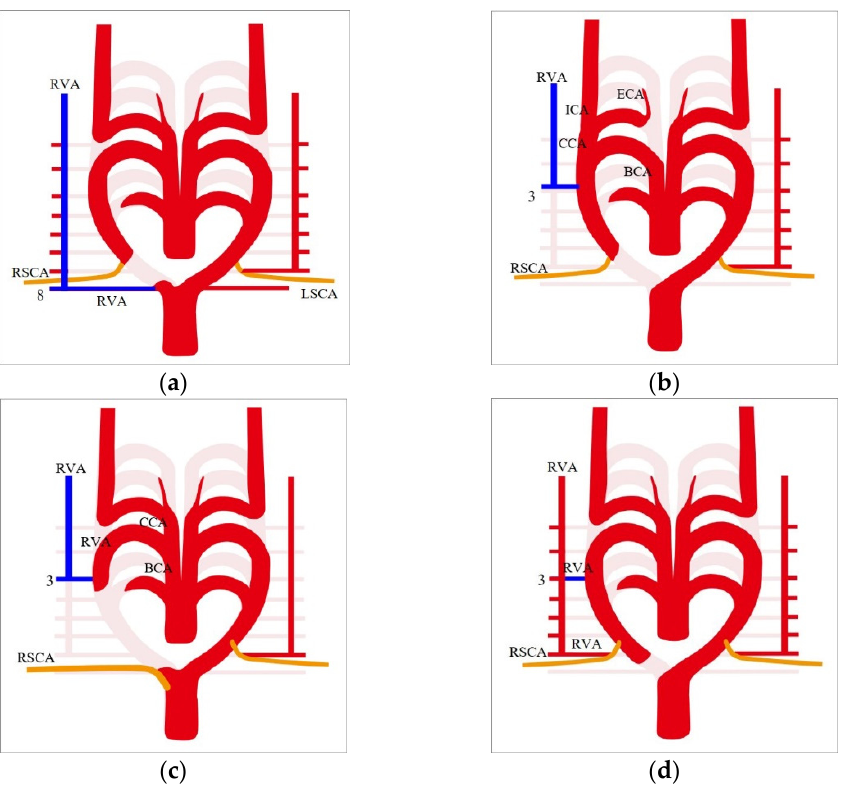
Figure 2. Drawing of the variations of the anomalous origin of the RVA. ( a ) Aortic origin of the RVA originating at the distal segment of the aortic arch beyond the origin of the LSCA. ( b ) Common carotid or brachiocephalic arterial origin of the RVA. ( c ) Common carotid or brachiocephalic arterial origin of the RVA with aberrant RSCA. ( d ) Double origin of the